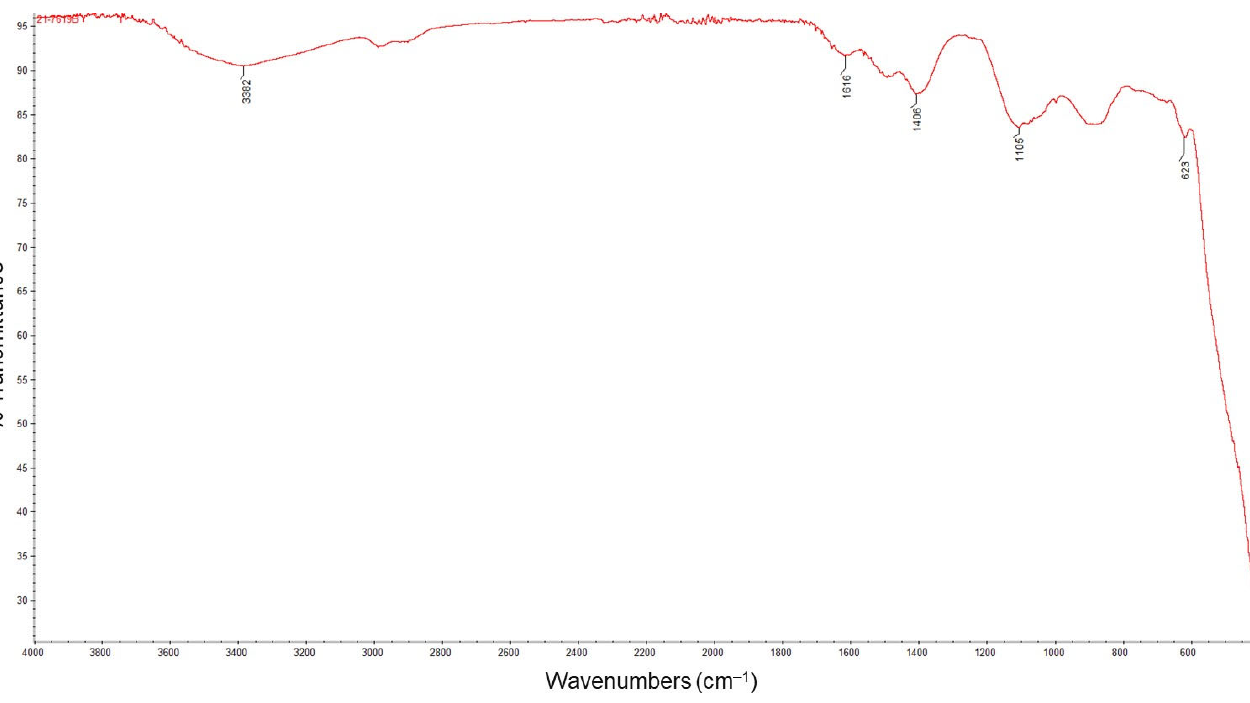
Figure 2. FTIR spectrum of the biosynthesized ZnO NPs.